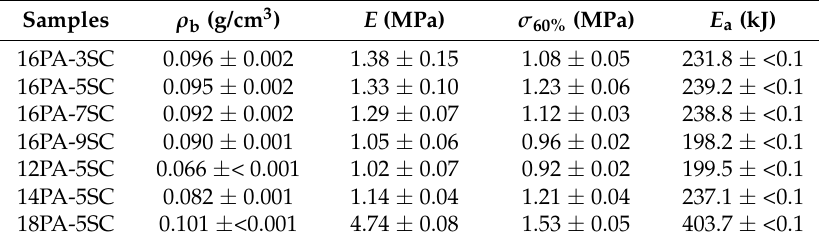
Figure 7. ( a ) Compressive curves of prepared PA foams and ( b ) stress–strain curves from uniaxial compression tests with intermittent unloading-reloading. Table 2. Compressive mechanical properties of PA foams.